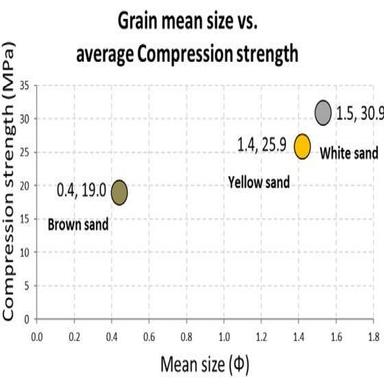
Grain mean size vs. average compressive strength.